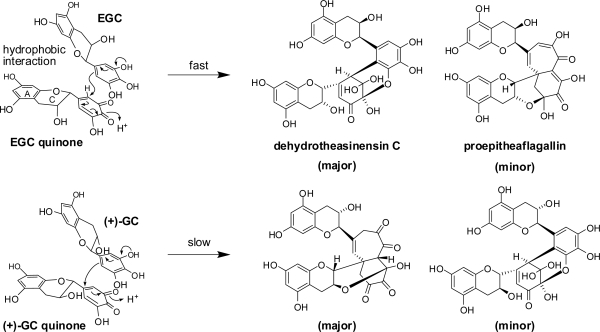
Difference of oxidative coupling of EGC and GC [41].